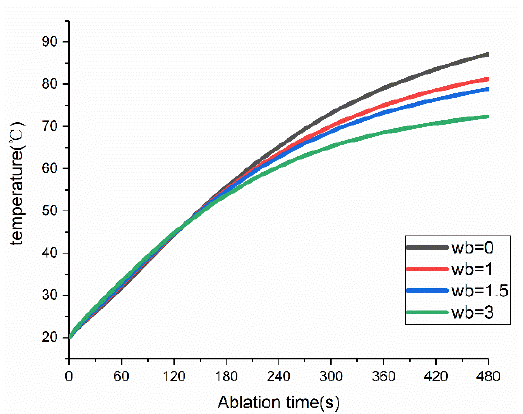
Figure 6. Temperature rising curves at point P1 under three different blood perfusions (dual-antenna spacing: 30 mm; heating parameter: 50 W matrix input power, and 8 min treatment time). Table 5. Reduction in coagulation zone volume under three types of blood